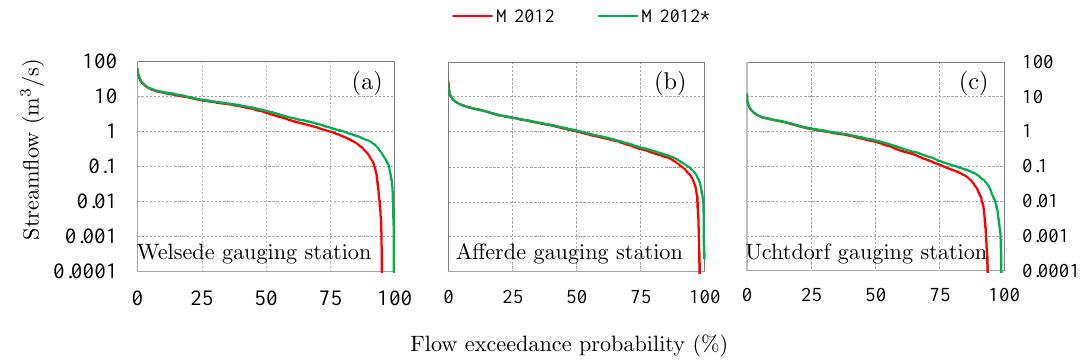
Figure 3. Flow duration curves of the simulated streamflow (logarithmic scale) at the ( a ) Welsede, ( b ) Afferde, and ( c ) Uchtdorf gauging stations during 1990–2000 with M2012 and